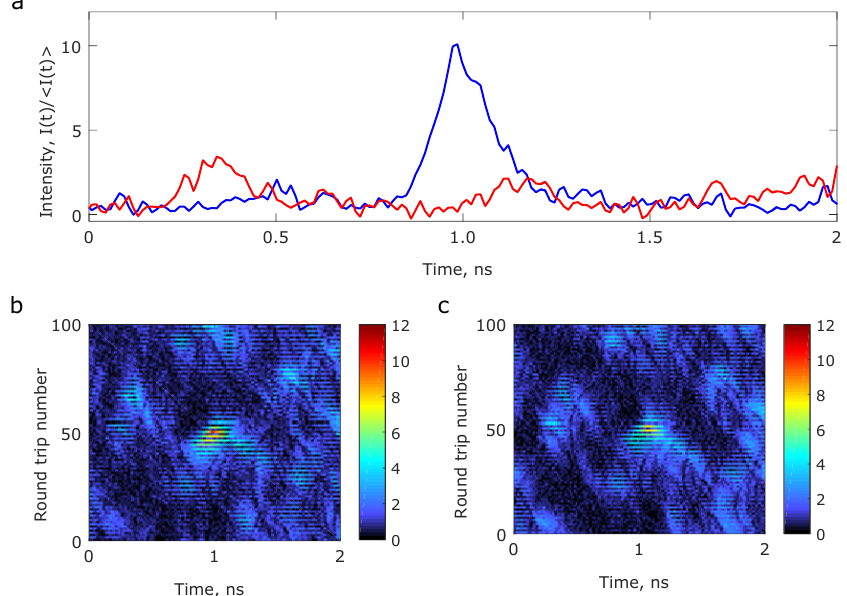
Figure 4. Polarized rogue waves in the Raman fibre laser—( a ) Experimentally measured polarization resolved intensity dynamics of the Raman fibre laser, and ( b , c ) corresponding polarization resolved spatio-temporal dynamics (( b )—blue curve, ( c )—red curve), revealing the existence of linearly polarized rogue